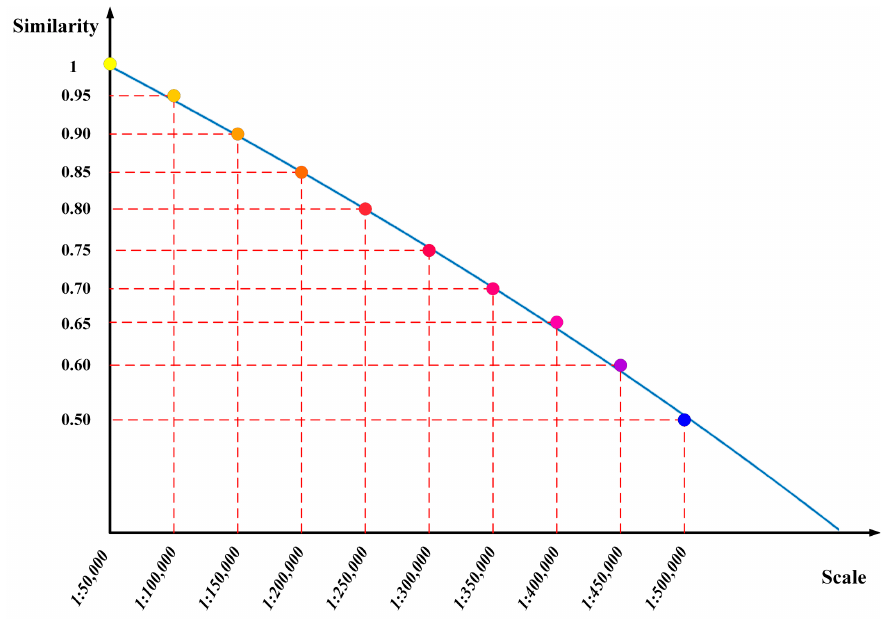
Figure 7. Ideal relationship between scale and similarity for continuous multi-scale simplification. The transitions of gradual simplification from L (cid:48) 0 to L (cid:48) n were emulated by the in- tersections of the CCS-mesh and the horizontal plane. To generate a simplified contour cluster from L (cid:48) 0 to L (cid:48) n , each horizontal plane was assigned the height value Z i in the equal interval sequence. Given that the relationship between the scale and similarity of different scale contours can be fitted with an exponential regression function and that the trend is continuously monotonic, according to Equation (9) and based on the similarities derived by Z i values, an interpolation function R s ( L (cid:48) 0 , L (cid:48) n , t ) was formulated to characterize the transition. t is a scaling parameter with values ranging from 0 to 1 that can be used to bridge the continuous scales between L (cid:48) 0 and L (cid:48) n by mapping Z i . By referring to the scales of L (cid:48) 0 and L (cid:48) n , t can be linearly converted into common actual scales. When t is 0, the scale is the initial scale of L (cid:48) 0 , but when t is 1, the scale is the target scale of L (cid:48) n . In turn, the contour cluster can be ordered by t . According to the interpolation function R s , the arbitrary scale of the simplified contours can be determined by the t value and its corresponding Z i value. In sum, each simplified contour has a determined scale and similarity with L (cid:48) 0 . Therefore, the proposed method can achieve arbitrary scale